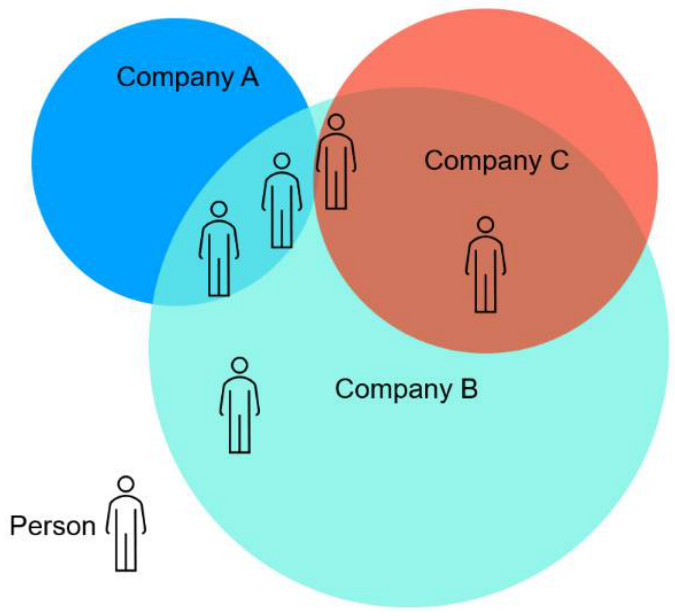
Figure 7. The overlapping nature of construction projects [65].